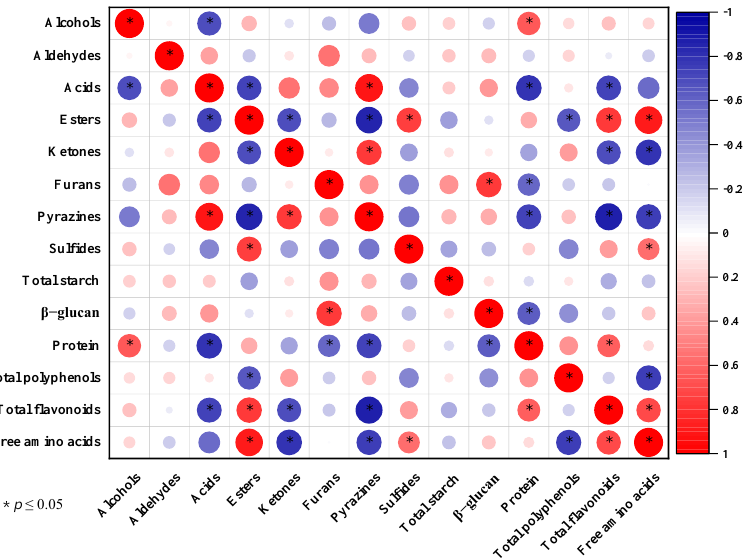
Figure 4. Correlation plot of the chemical composition and the volatile substances of the raw and CHB roasted at different temperatures.